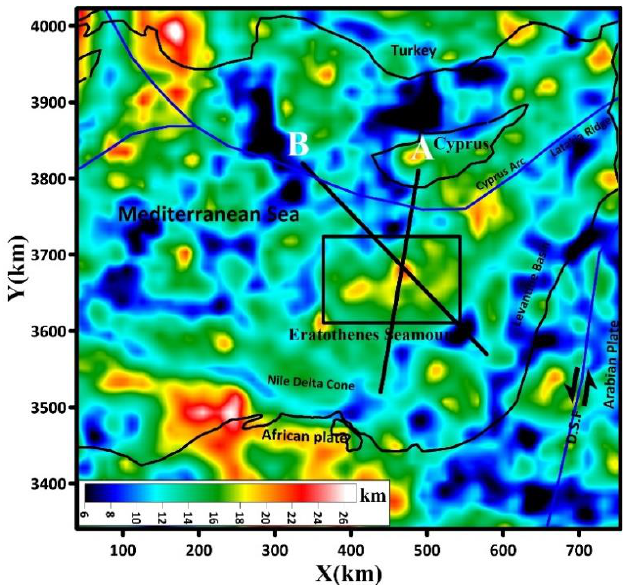
Figure 5. Curie point depth for the Eratosthenes Seamount.